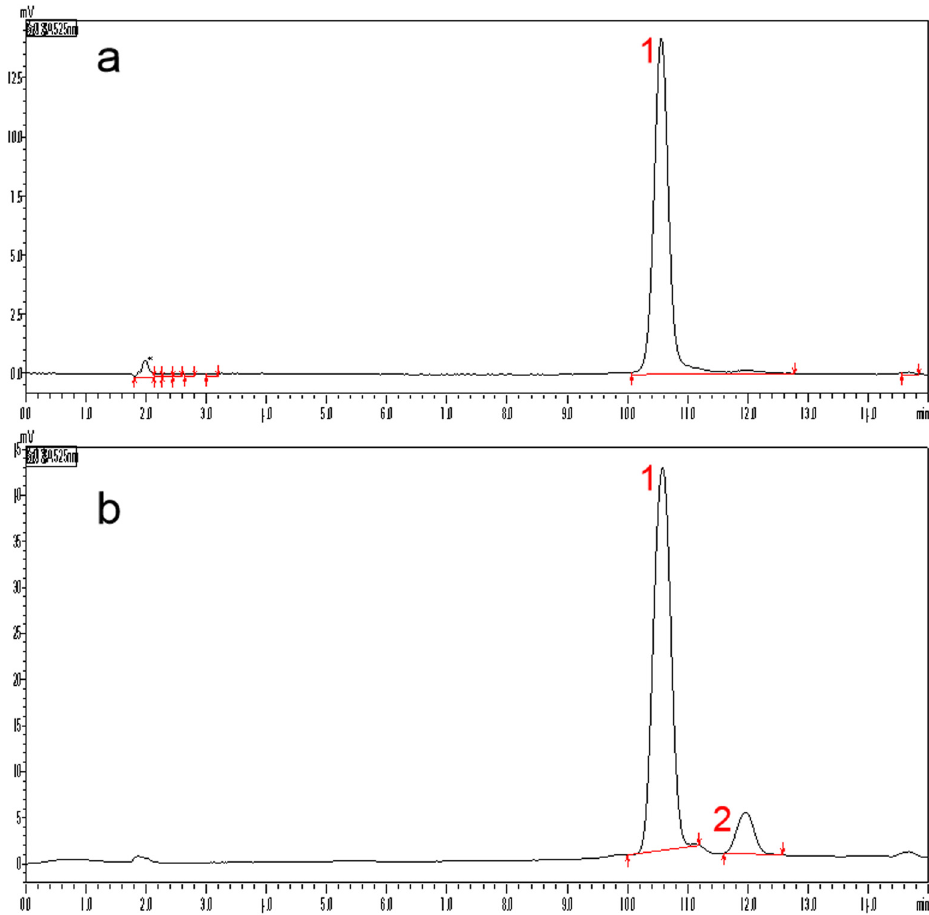
Figure 2: HPLC chromatogram of BRAE detected at 520 nm for anthocyanins. ( a ) C3G HPLC grade standard chemical and ( b ) BRAE. Peak 1,